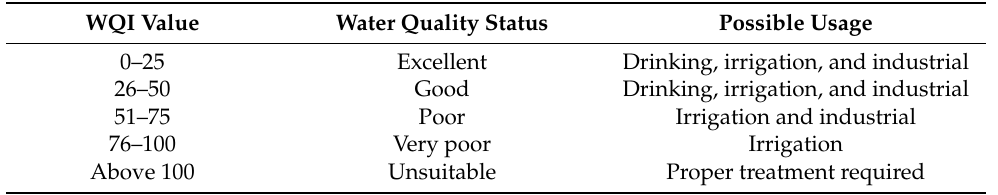
Table 2. Water quality classification based on WQI values